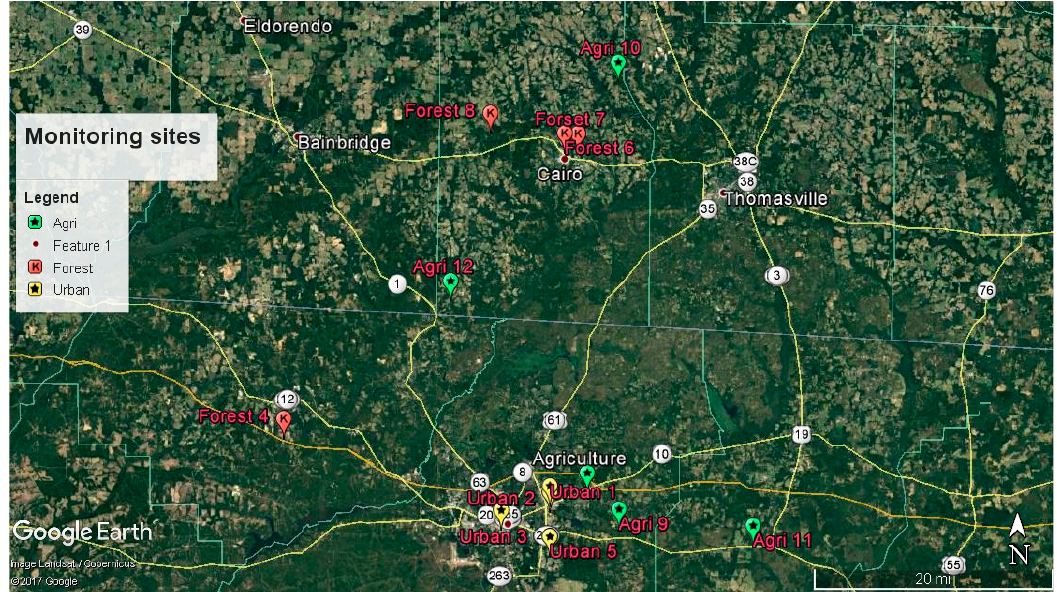
Figure 1. Map showing monitoring sites for Paratelenomus saccharalis in north Florida and south Georgia, 2016 and 2017.